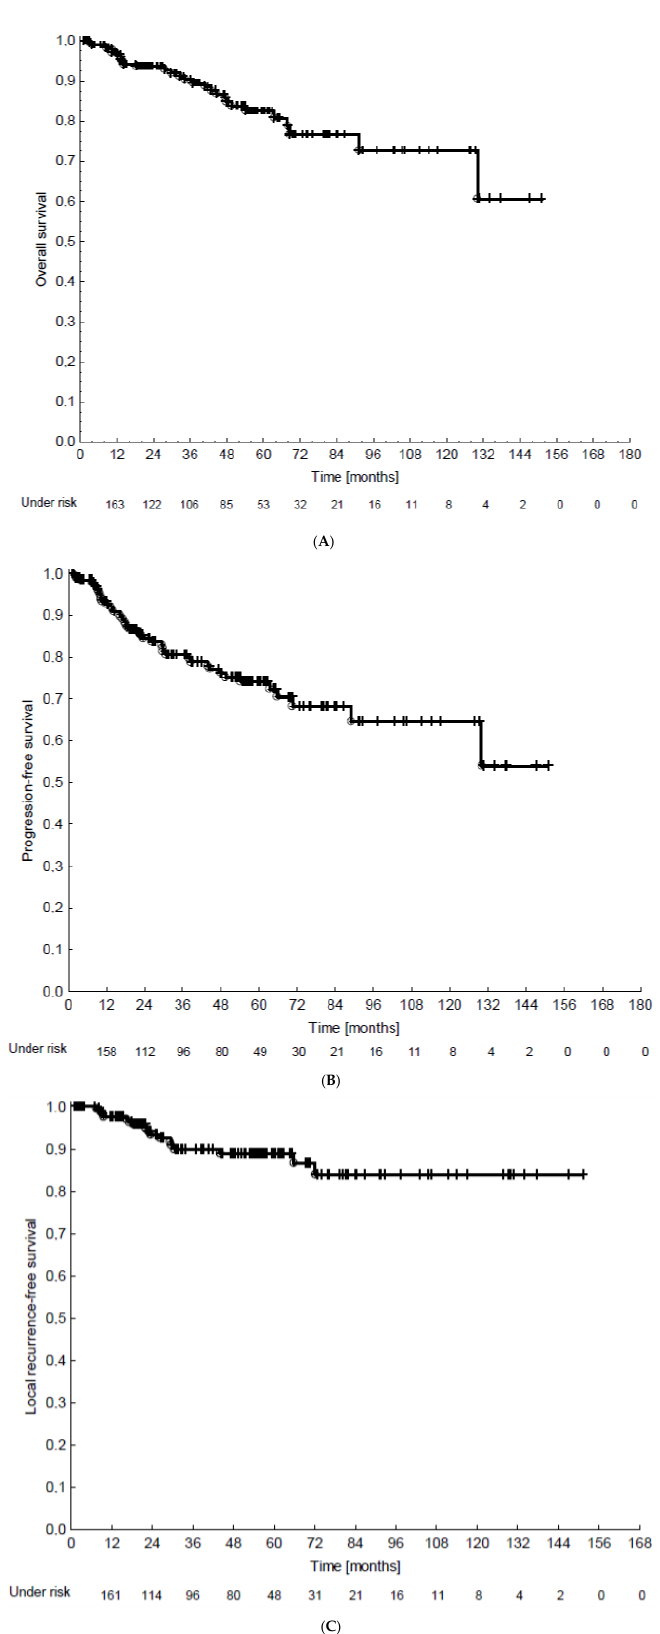
Figure 1. ( A – C ): Patient survival in the whole cohort (overall survival, progression-free survival, and locoregional recurrence-free survival).